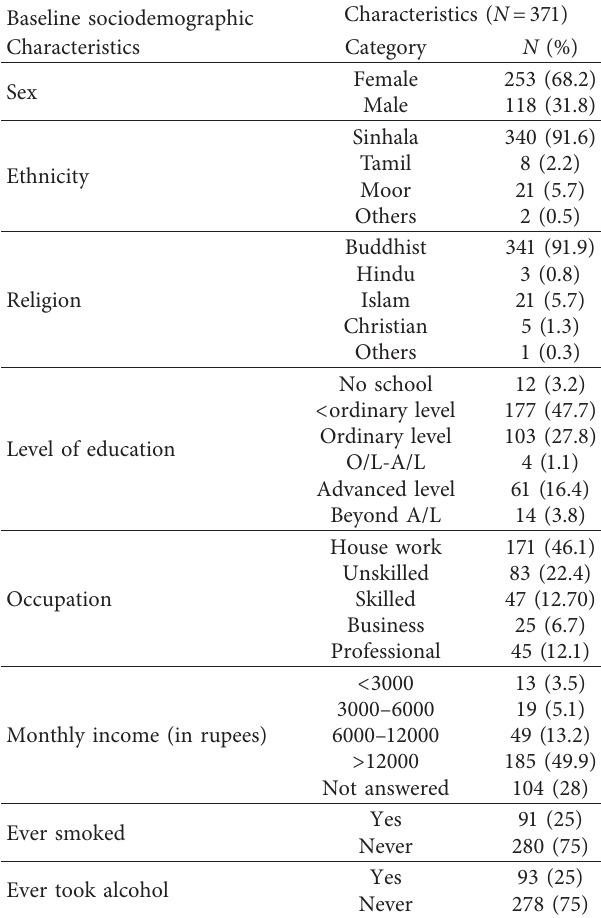
Table 1: Baseline sociodemographic characteristics of the patients participated in the